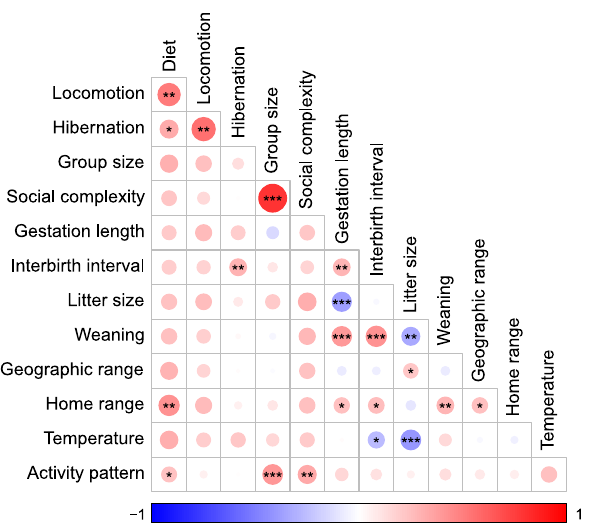
Fig. 5 Correlation between the different predictors used in this study. Correlation matrix of the ecological, environmental, social, and life-trait history predictors tested in this study with associated values and p -values. Negatively correlated variables are shown in blue while those positively correlated are coloured in red. The statistical signi fi cance of each correlation is signi fi ed by asterisks whereas size of the circle is de fi ned by the correlation strength. Asterisks indicate the level of signi fi cance (*0.05; **0.01 and ***0.001 within insular systems compared to mainland populations 76 .